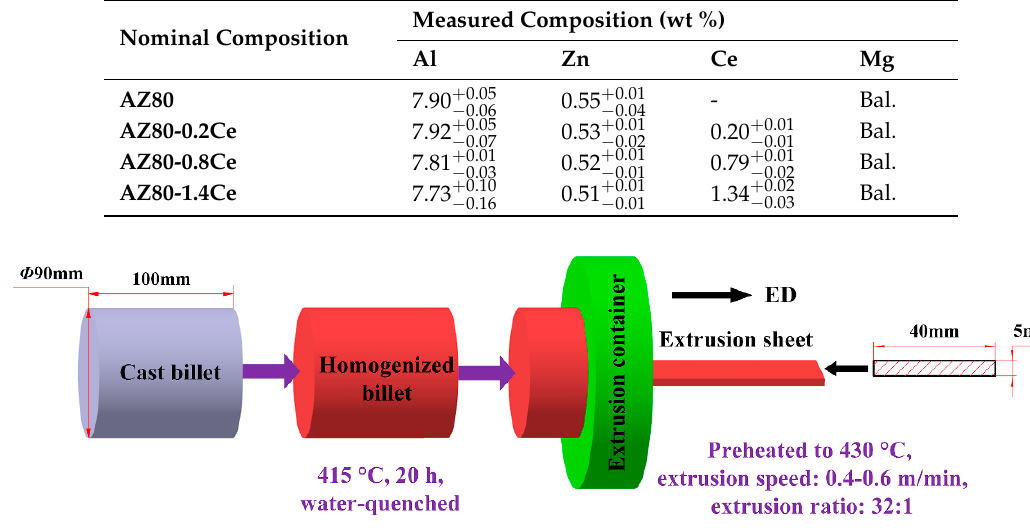
Figure 1. The schematic diagram of the extrusion process in this work.